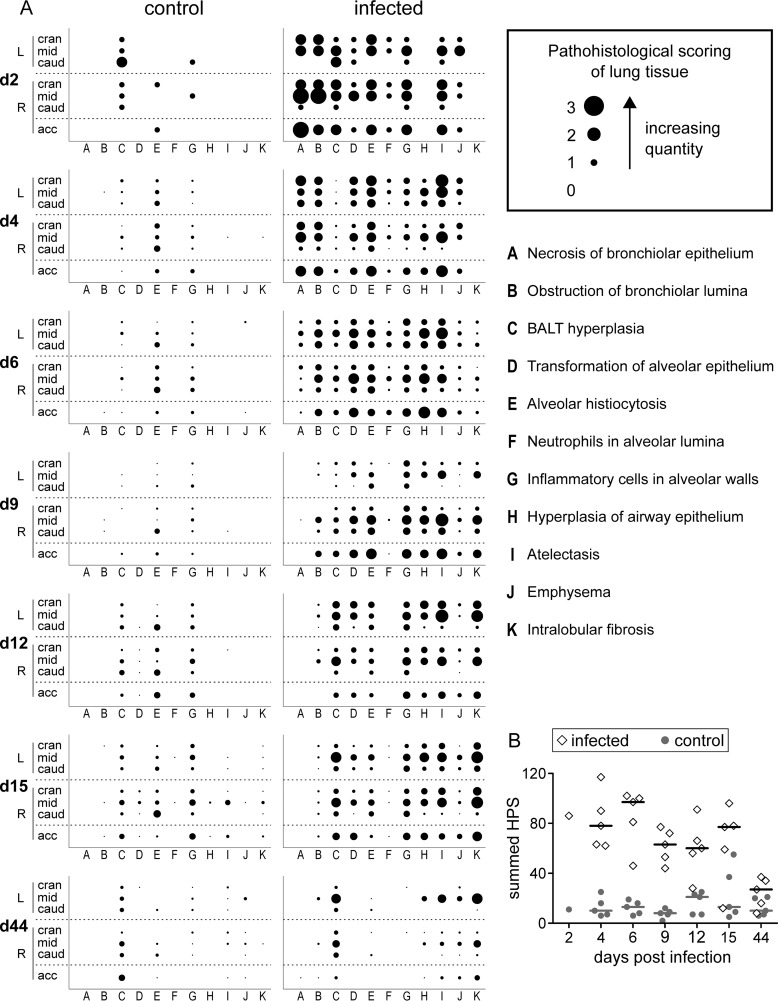
Histopathology of lung tissue. (A) Paraffin sections of all seven lung lobes (left cranial, middle, and caudal and right cranial, middle, caudal, and accessory) from PBS-treated control pigs and FLUAVsw-infected pigs were stained with hematoxylin and eosin and examined for the presence and quantity of parameters A to K (defined in the figure). The quantity and presence of each parameter were recorded as a score (0 [absent] to 3 [high grade]). Dot sizes represent the score for one individual animal (day 2) or the mean score for five animals (days 4 to 44). (B) Histopathology scores (HPS) were summed for each individual animal (infected, diamonds; control, gray dots). Horizontal bars indicate the median value for five animals.